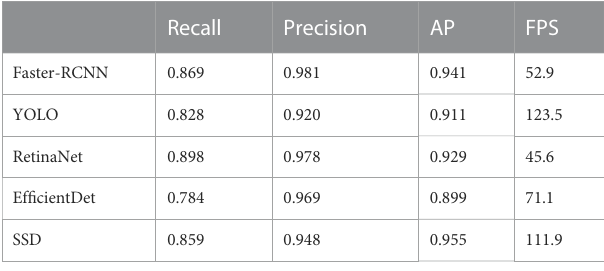
TABLE 1 Detection performance comparison of fi ve models.